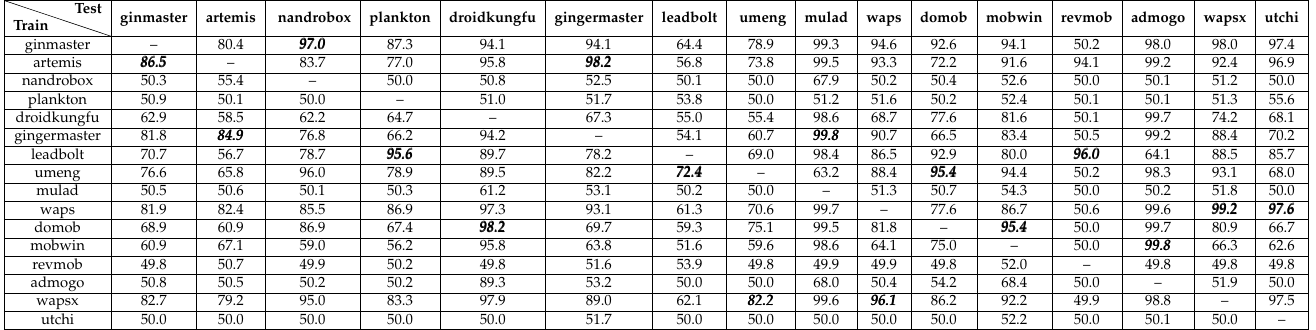
Table 6. Malware detection performance with different malware families in the training set using droidsieve. The number in bolds show the best